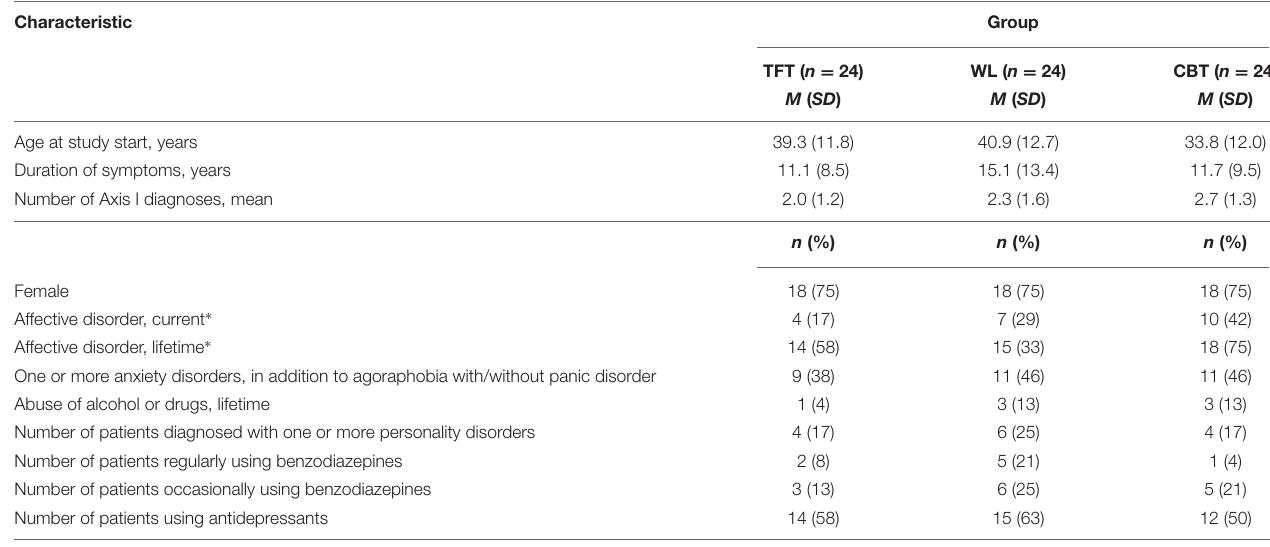
TABLE 1 | Demographic data for the three original groups.